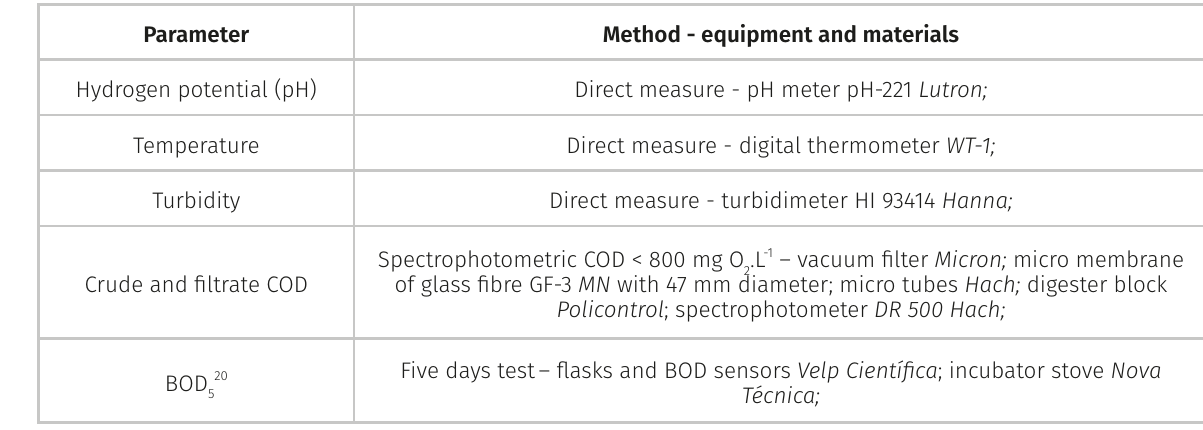
Table I . Methods, equipment and/or materials used to measure physicochemical parameters to characterize crude leachate and monitor photocatalytic ozonation